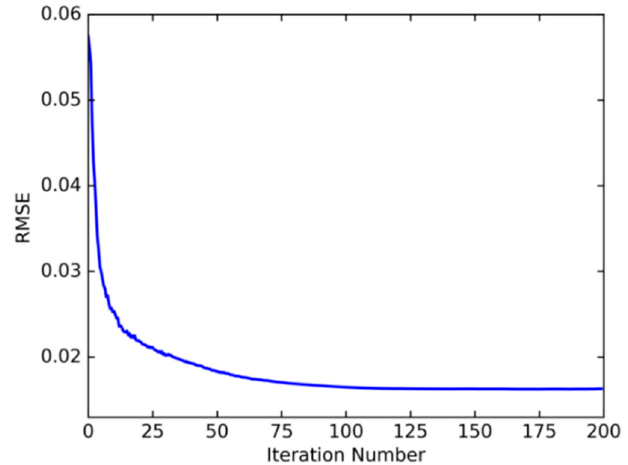
Figure 10. Root mean squared error convergence.